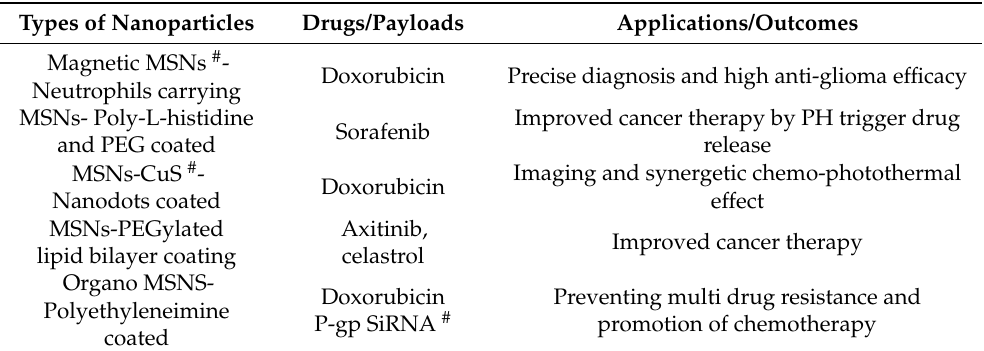
Table 6. Applications of MSNs using cancer models for improved cancer therapy. Reproduced with permission from reference [106].